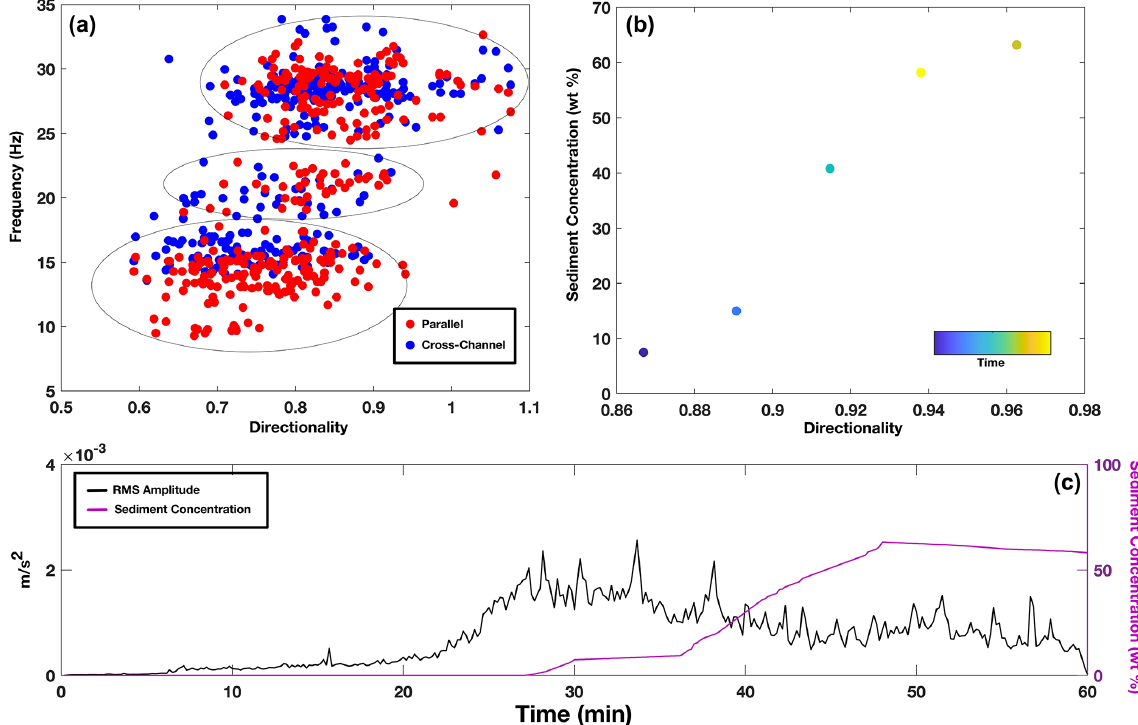
Figure 8. Plots of (a) comparing PSF and DR at TRAN, (b) sediment concentration and DR at COLL ( R 2 = 0 . 95), and (c) seismic amplitude (black line) with sediment concentration (purple line) depicting the lag in sediment at COLL. Note on panel (a) parallel (red dots) and cross- channel (blue dots) PSFs display three different zones (black circles). Also note that at COLL the first sediment concentration measurement did not occur until the 30min